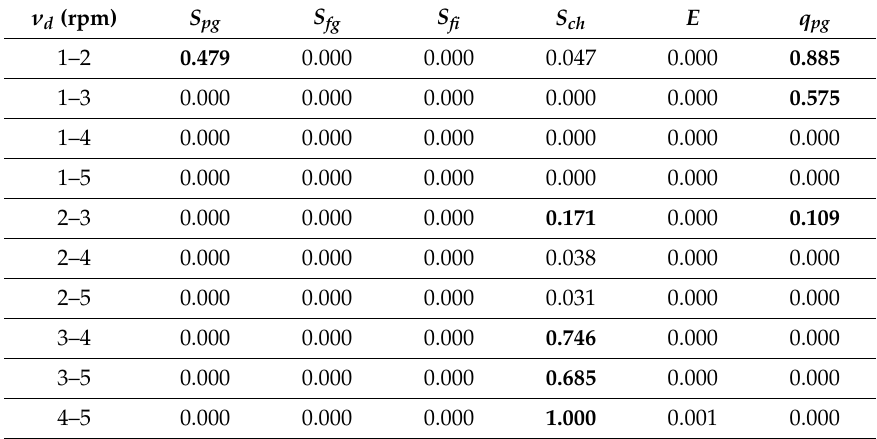
Table 5. Tukey’s honest significance di ff erence (HSD) test for the